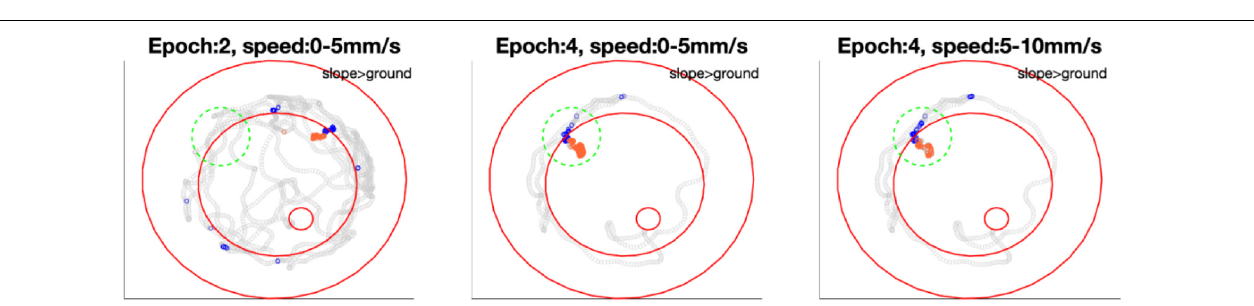
FIGURE 9 | Bee 140409 locations in * marked epochs of Figure 8 . In each subfigure, blue points highlight the bee locations on the slope in that epoch under certain speed, while orange points highlight locations on the ground in the same epoch and same speed. Gray points show other locations of the same epoch in all speeds. Three red open circles, from small to big, mark the feeding place, edge of ground paper and rim of arena. The comparison of mean spike numbers between blue and orange points is displayed in the up-right corner of each subfigure. Note that in the area marked with a green dashed circle, the unit was not significantly more active in epoch 2 on either slope or ground, however, it was more active on the slope when the bee revisited this area in epoch 4. Different significant locations in different epochs indicate that in Figure 8 the inconstant difference over time is caused by time instead of revisiting of the same location. More examples of other units are in Supplementary Figure S6